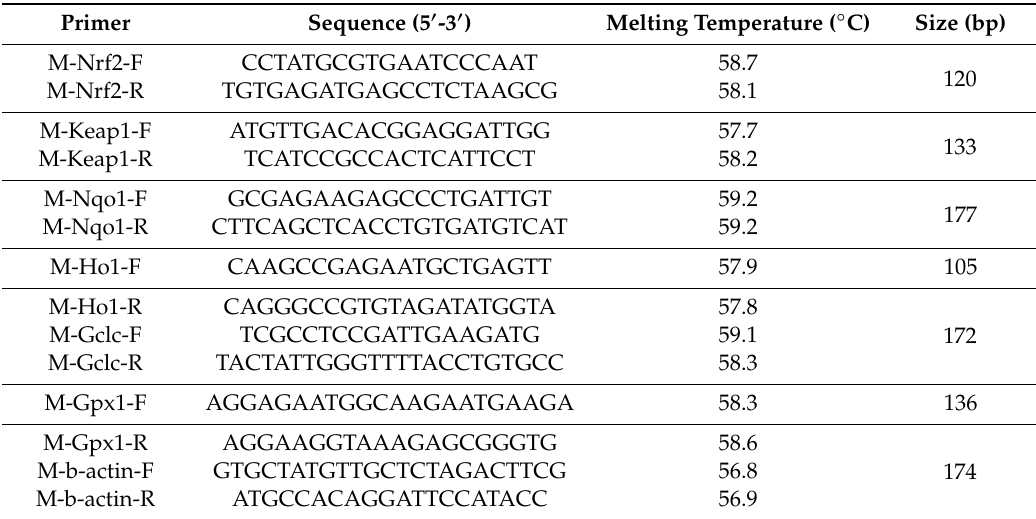
Table 1. The sequences of primers used to amplify the target